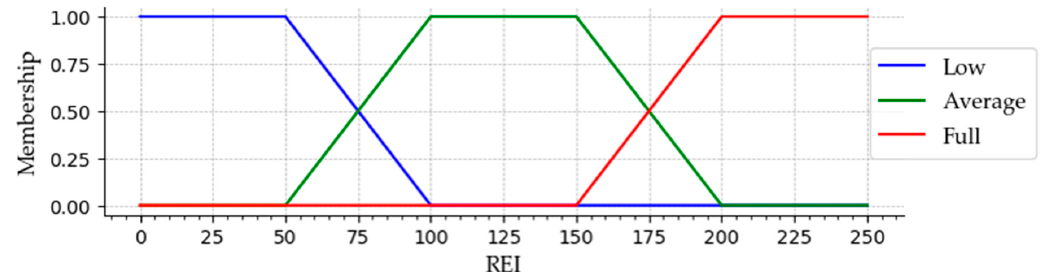
Figure 5. Input variable of queue fluctuation index (QFI). The variable represents the resource availability in a path.